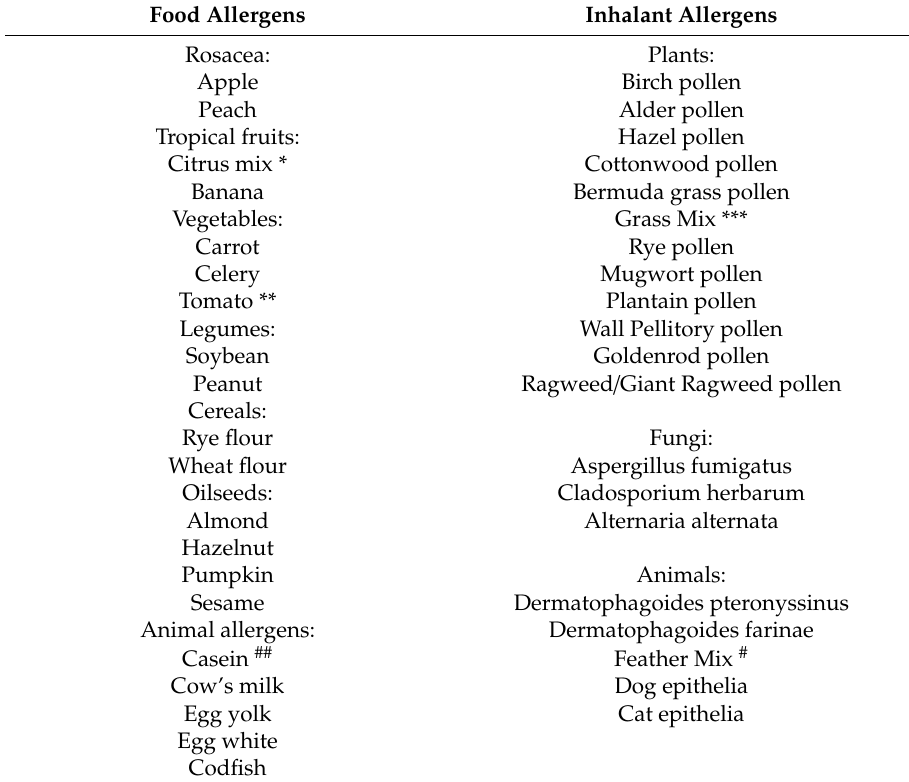
Table 1. Food and inhalant allergens tested